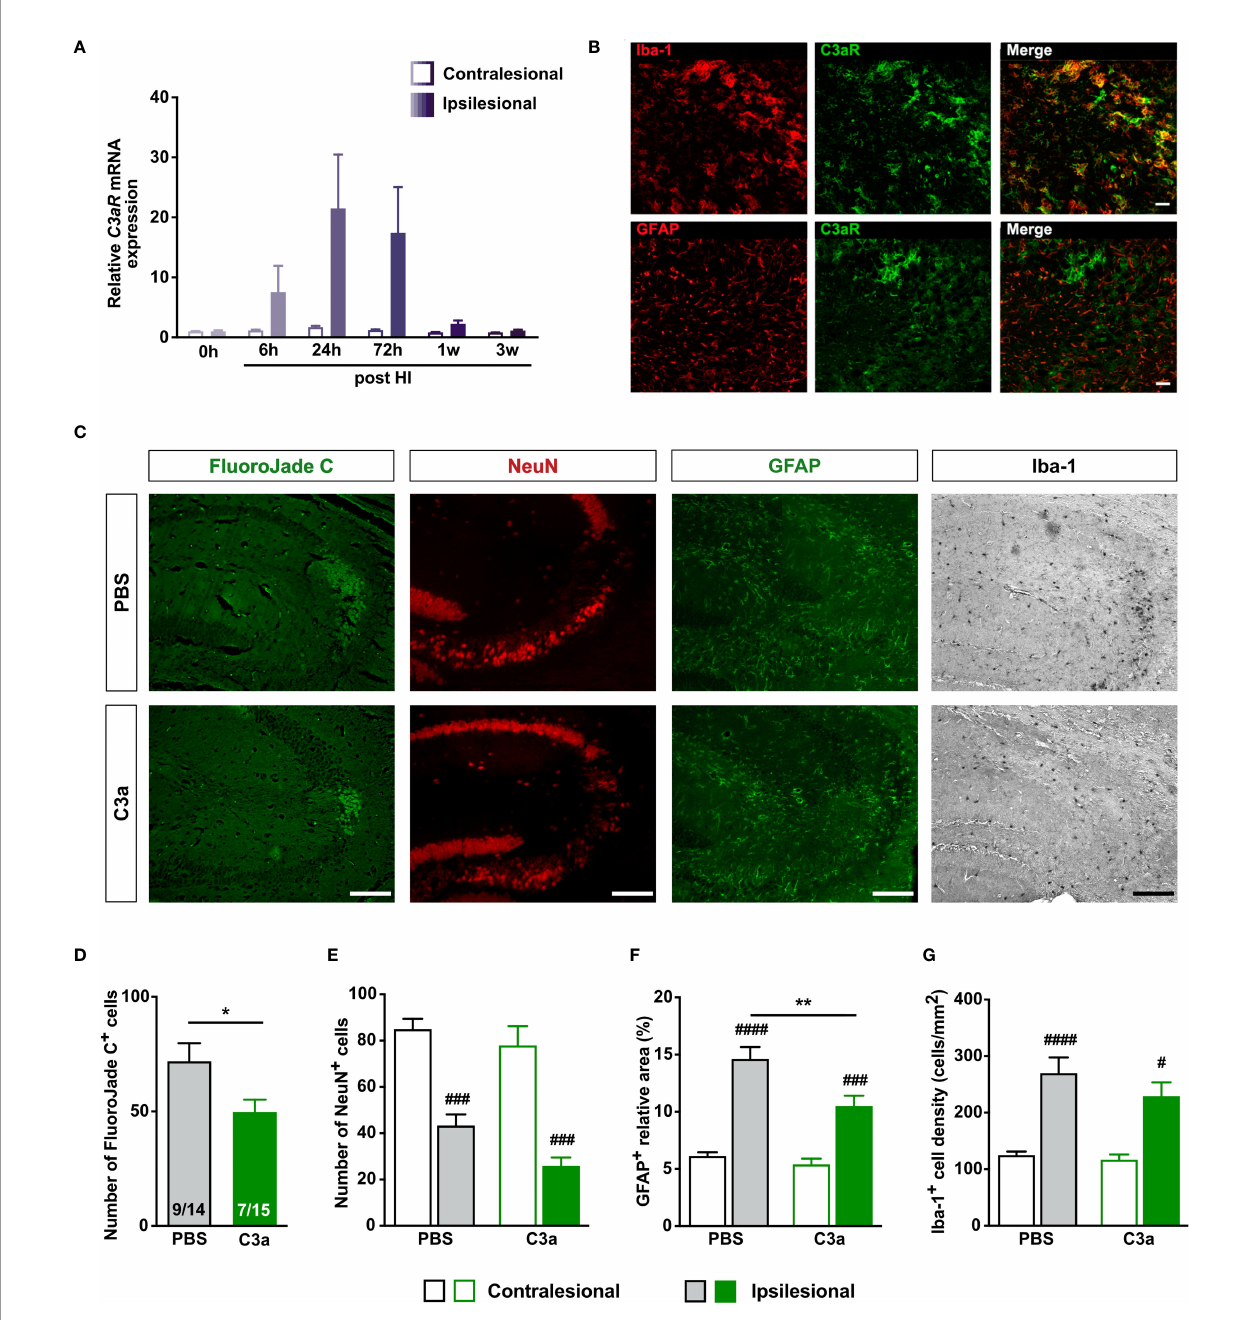
FIGURE 5 | Intranasal C3a treatment reduces HI-induced neurodegeneration and reactive astrogliosis in WT mice treated with PBS or C3a. (A) Relative expression of C3aR mRNA after HI. n = 3. (B) In the ipsilesional CA3 3 days after HI, C3aR is expressed predominantly by Iba-1 + microglia. Scale bar = 50 µm. (C) Representative images of ipsilesional CA3 stained with FJC and antibodies against NeuN, GFAP and Iba-1 7 weeks after HI induction. Scale bar = 50 µm. (D – G) Number of FJC + cells (D) , number of NeuN + cells (E) , relative GFAP + area (F) , and (G) density of Iba-1 + cells in CA3. IL, ipsilesional; CL, contralesional. * P < 0.05, ** P < 0.005 vs PBS; # P < 0.05, ### P < 0.001, #### P < 0.0005 vs contralesional. Data were analyzed by two-tailed unpaired t test (D) or two-way ANOVA and Tukey ’ s posthoc test (E – G) . Numbers in bars (D) indicate number of positive mice/total number of mice. (E – G) n = 13 – 14 (PBS) and 9 – 15 (C3a). Values are mean ± show that transgenic overexpression of C3a in reactive astrocytes decreases HI-induced neurodegeneration, whereas genetic de fi ciency of C3aR has the opposite effect. These results provide